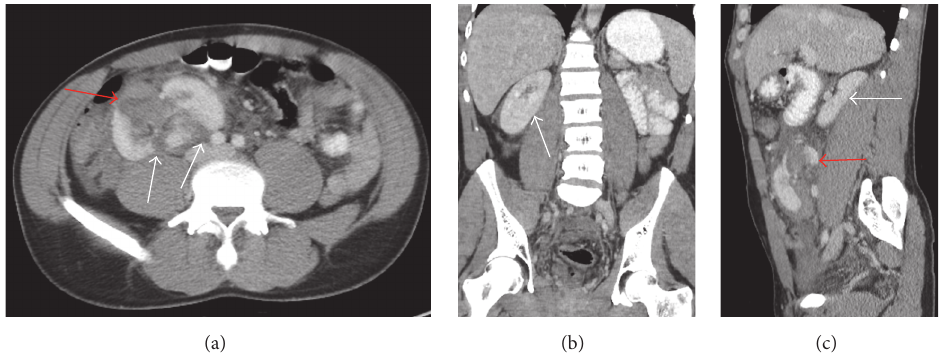
Figure 2: 31-year-old male with crossed unfused renal ectopia. Axial contrast-enhanced CT image (a) shows lacerations (white arrows) through the posterior cortex of the ectopic left kidney, positioned anteriorly and inferiorly in the right abdomen. A perinephric hematoma (red arrow) is noted anteriorly. A coronal CT image (b) shows the uninjured right kidney in a normal location. A sagittal CT image (c) through the right abdomen shows the right kidney (white arrow) in a normal location in the renal fossa and the ectopic kidney (red arrow) in the lower right abdomen. Note the gap between these kidneys in this unfused